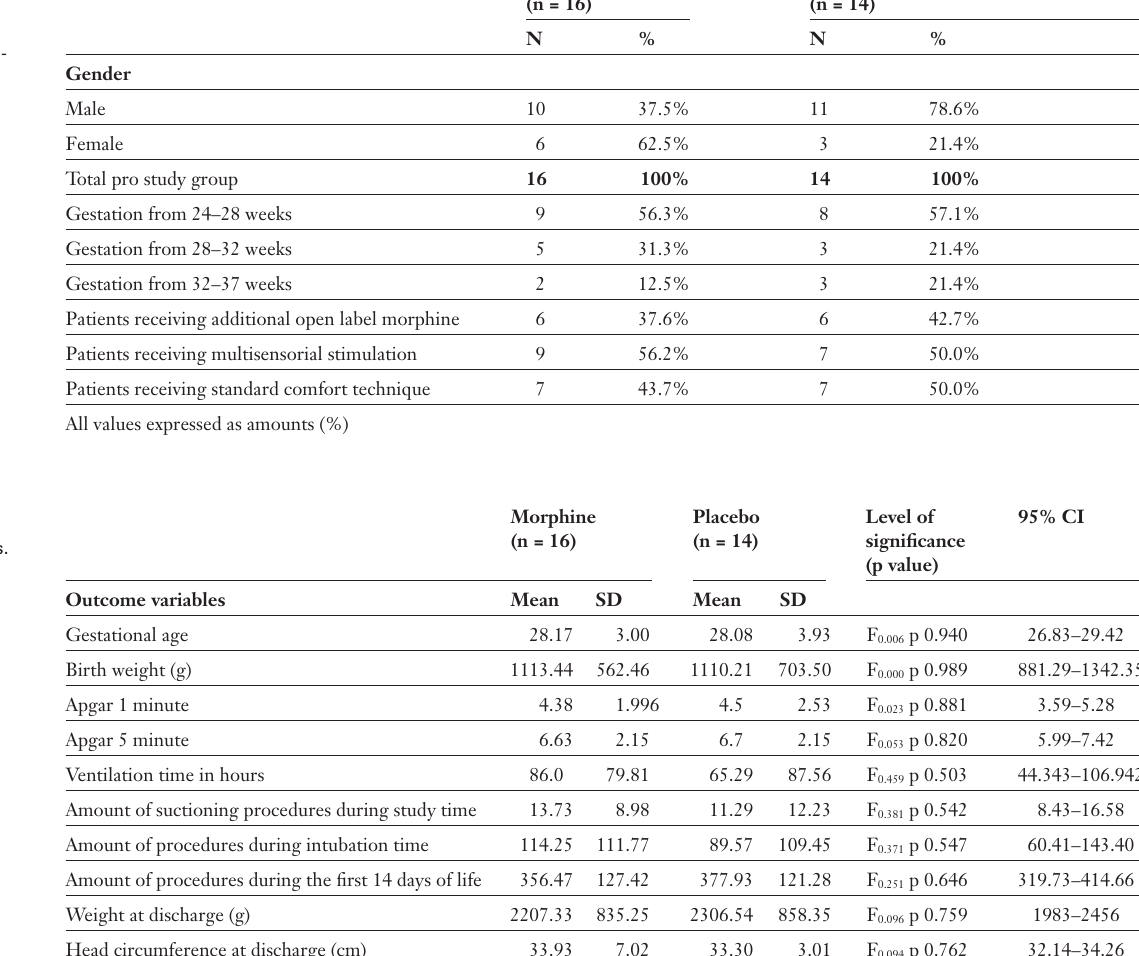
Background demographic and clinical characteris- tics.